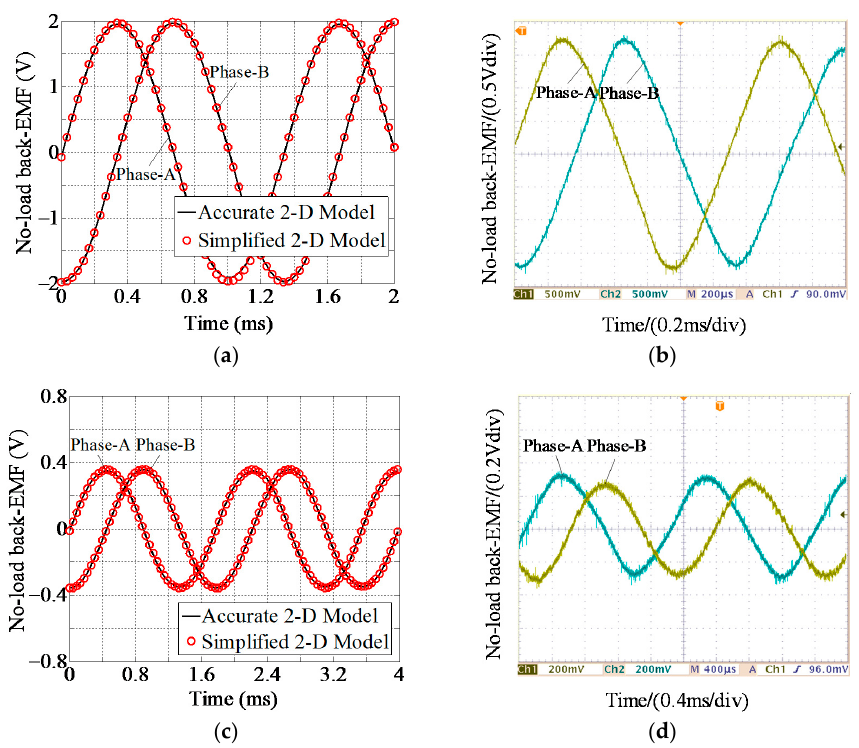
Figure 14. Comparison of calculated and measured no-load back-EMF. ( a ) Calculated EMF of sub-motor1 at θ = 49.5°; ( b ) Measured EMF of sub-motor1; ( c ) Calculated EMF of sub-motor2 at θ = 45°; ( d ) Measured EMF of sub-motor2.